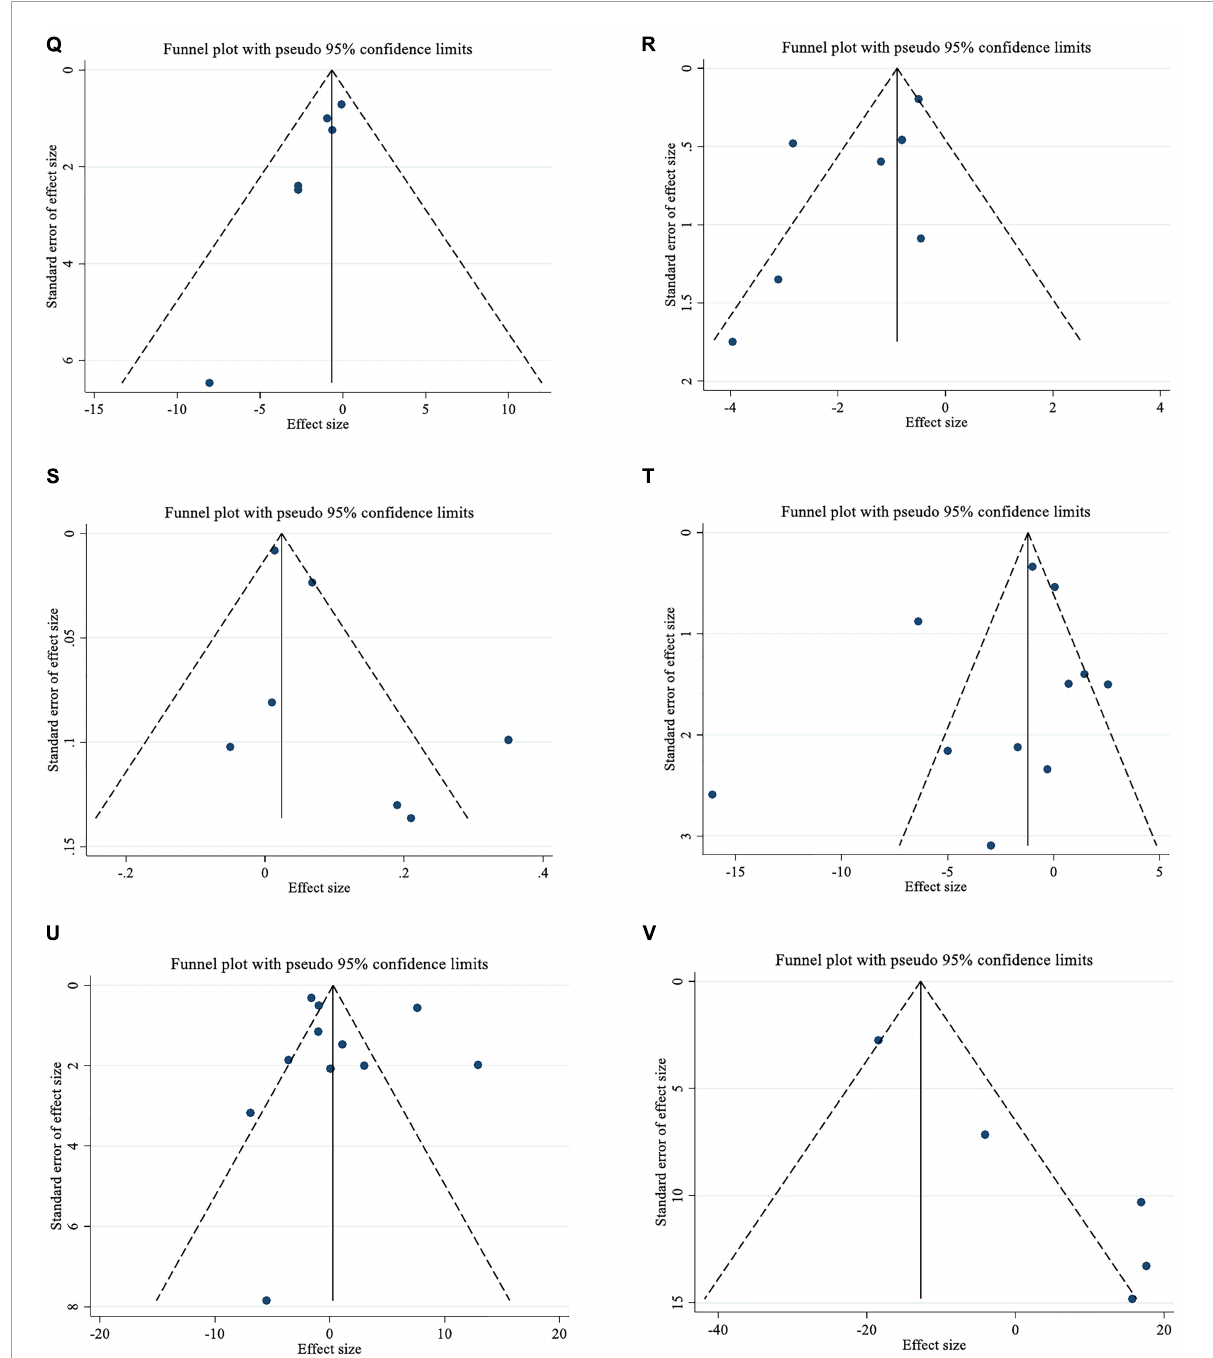
FIGURE3 Funnel plots for the effect of saffron consumption on (A) TG (mg/dl); (B) TC (mg/dl); (C) LDL (mg/dl); (D) HDL (mg/dl); (E) FBG (mg/dl); (F) Insulin (miu/ml); (G) HbA1c (%); (H) HOMA-IR; (I) SBP (mmHg); (J) DBP (mmHg); (K) CRP (mg/l); (L) ; IL-6 (pg/ml); (M) TNF- α (pg/ml); (N) weight (kg); (O) BMI (kg/m 2 ); (P) WC (cm); (Q) FM (%); (R) MDA (uM/L); (S) TAC (mM/L); (T) ALT (U/L); (U) AST (U/L) and (V) ALP (U/L). TG, triglyceride; TC, total cholesterol; LDL, low-density lipoprotein; HDL, high-density lipoprotein; FBG, fasting blood glucose; HOMA-IR, homeostasis model assessment for insulin resistance; HbA1c, hemoglobin A1c; CRP, C-reactive protein; IL-6, interleukin 6; TNF- α , tumor necrosis factor; TAC, total antioxidant capacity; BMI, body mass index; WC, waist circumference; FM, fat mass; ALT, alanine transaminase;